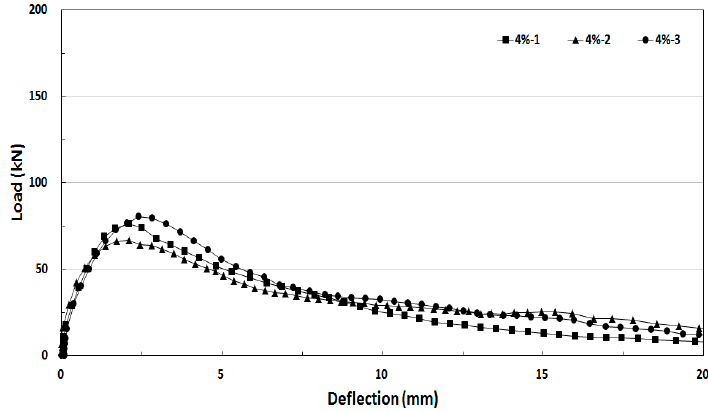
Figure 5. Load-mid span deflection curve at a fiber volume fraction of 4%.